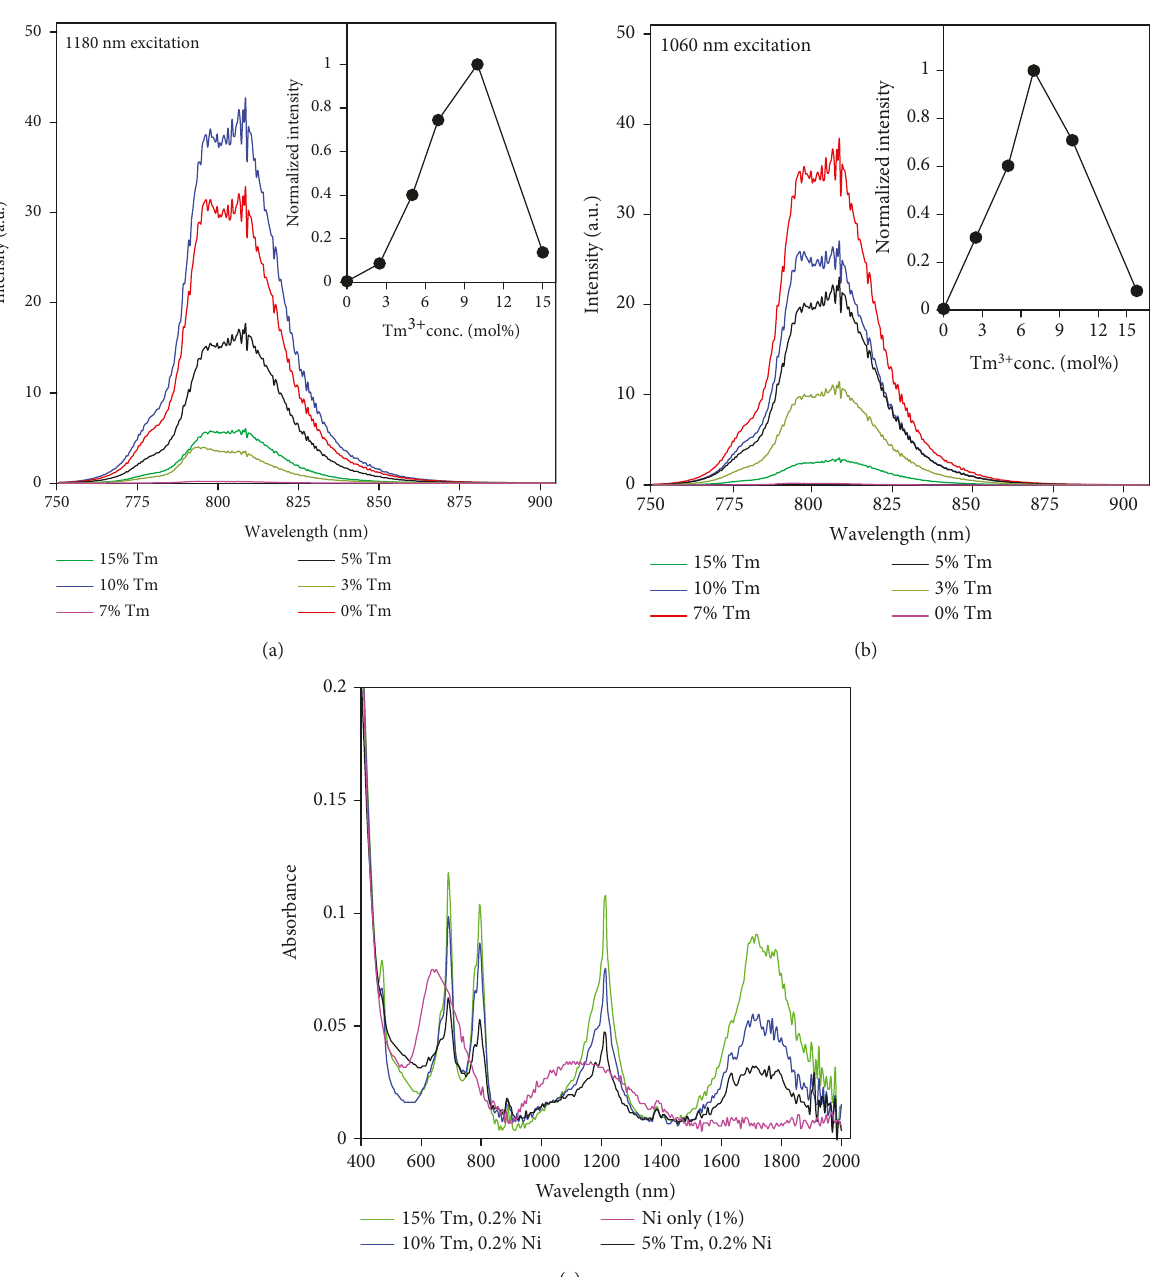
Figure 4: UC emission spectra of the CaTi O :Tm, Ni samples with variable Tm 3+ ion concentrations excited at (a) 1180nm (both Tm 3+ 0.9 3 and Ni 2+ absorption) and (b) 1060 nm (Ni 2+ -only absorption). (c) Absorption spectra of the corresponding samples. Note that the Ni 2+ concentrations are di ff erent in the Ni-only doped and Tm and Ni codoped samples in